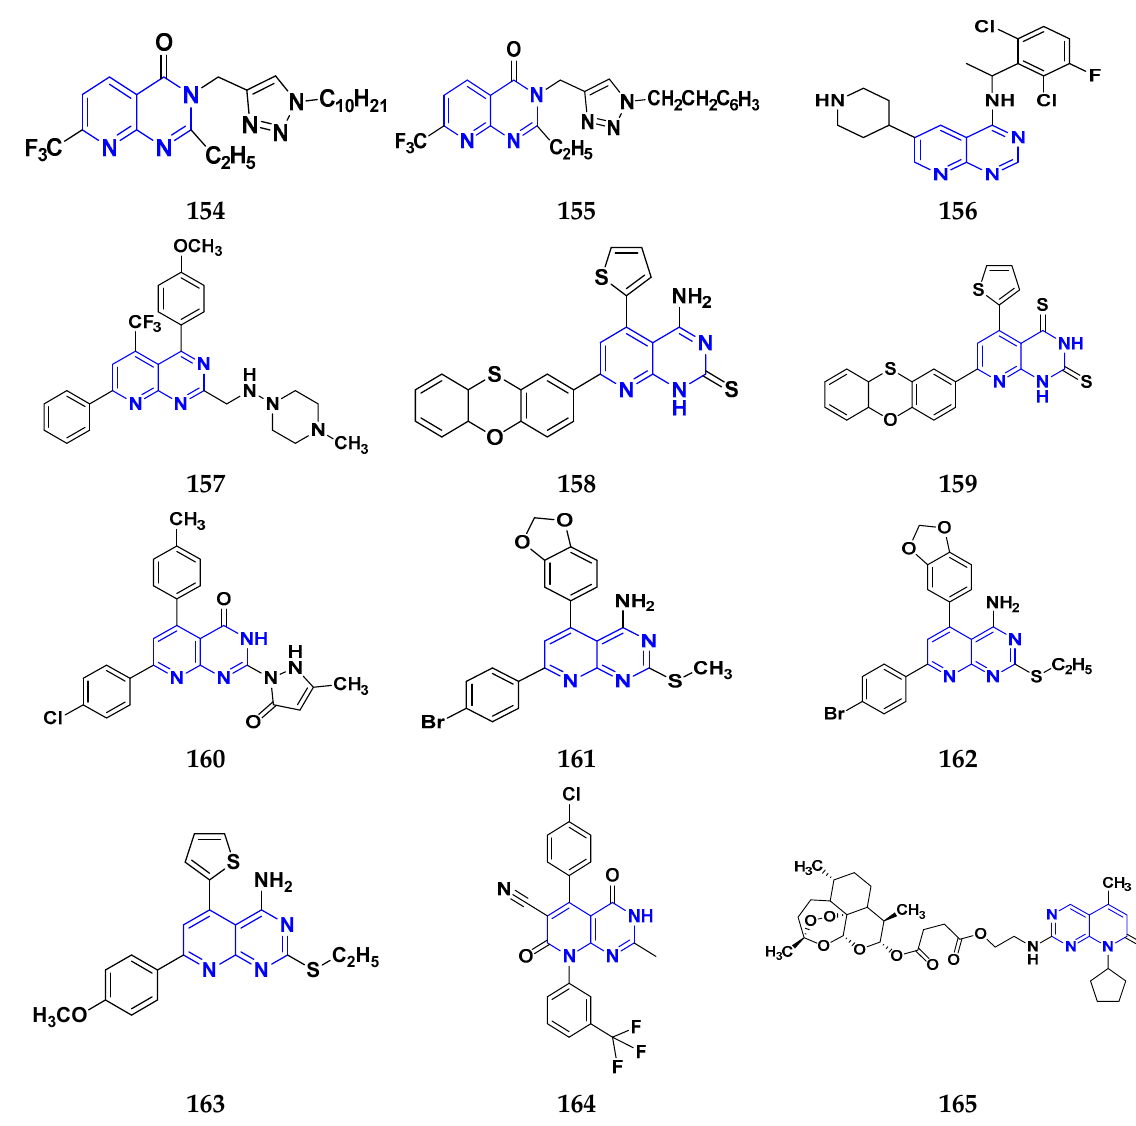
Figure 17. Pyrido[2,3-d] pyrimidine derivatives ( 154 – 165 ) as anticancer agents.